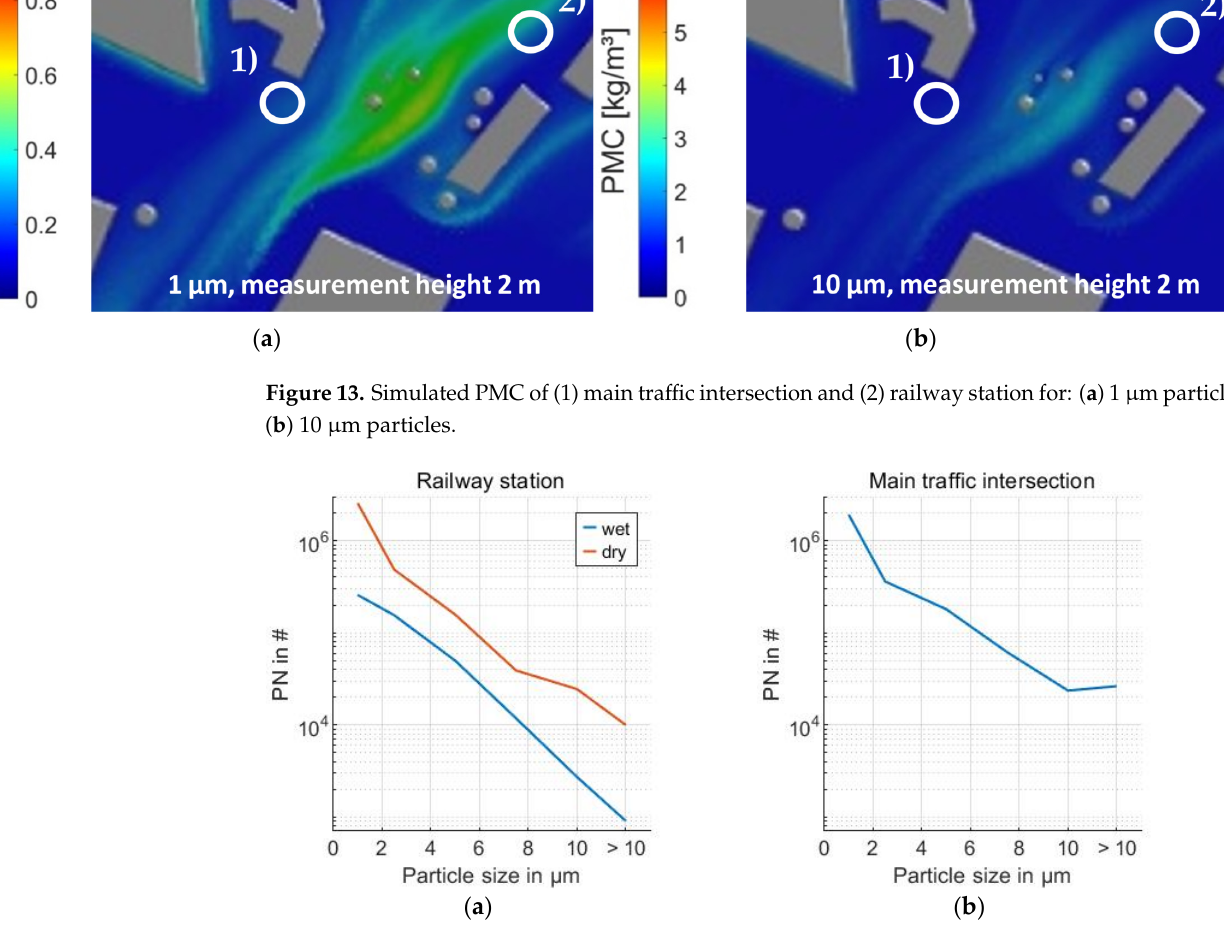
Figure 14. Comparing PSD of the real measurements: ( a ) railway station; ( b ) main traffic intersec- tion.